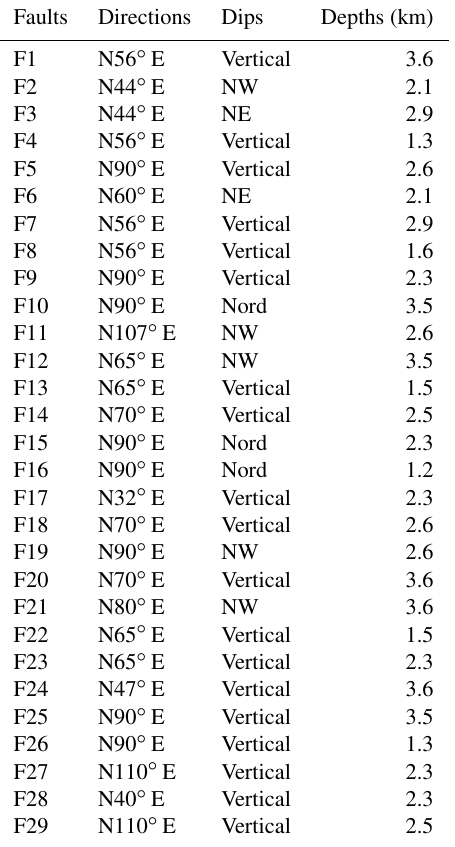
Table 3. Main faults of Lom series. This summary table is obtained after comparing the results from the Euler deconvolution method and the tilt derivative.